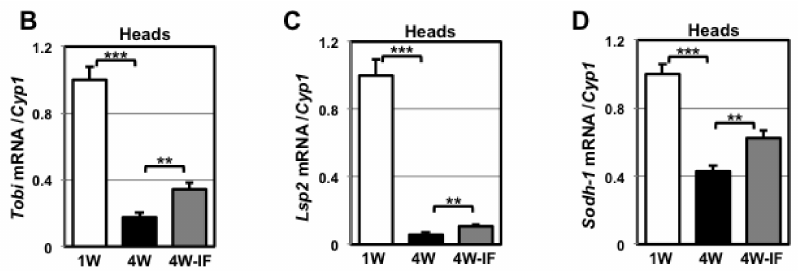
Figure 2. Age and IF-dependent fold changes (FC) to the expression profiles of metabolic pathway components in adult Drosophila heads. Quantitative RNA-sequencing and DAVID analysis identified metabolic genes that showed age and IF-dependent differences in expression levels. ( A ) Heatmap and corresponding table represents hierarchical clustering of scaled gene expression profiles and the respective fold change (FC) and p values between 4W/1W and 4W/4W-IF cohorts. Scaled expression values ( z -score) were plotted in red–blue color scale with red indicating high expression and blue indicating low expression levels. Arrows highlight lysosomal proteins involved with carbohydrate metabolism. ( B – D ) qRT-PCR of expression changes to the Tobi , Lsp2 and Sodh-1 genes in neural tissues. ** p ≤ 0.01, *** p ≤